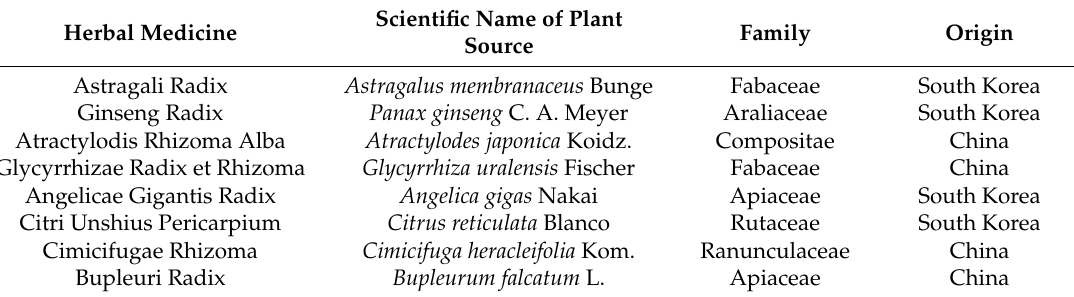
Table 3. Composition of